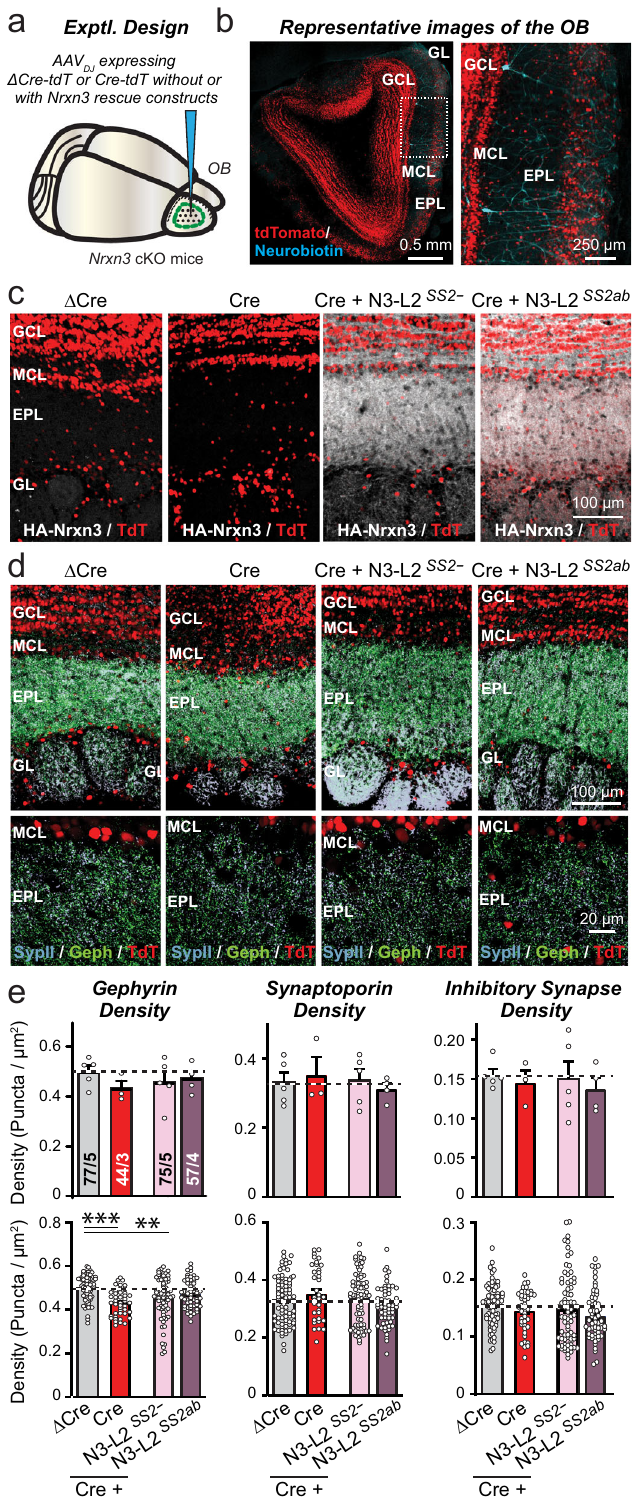
Fig.3|ConditionalinvivodeletionofNrxn3intheOBhasnoeffectonsynapse density,nordoesrescueoftheNrxn3deletionbyminimalNrxn3LNS2-domain constructs. a , b Experimental design of in vivo Nrxn3 deletions and rescues. The OB was stereotactically infected with AAVs expressing Δ Cre (control), Cre, or